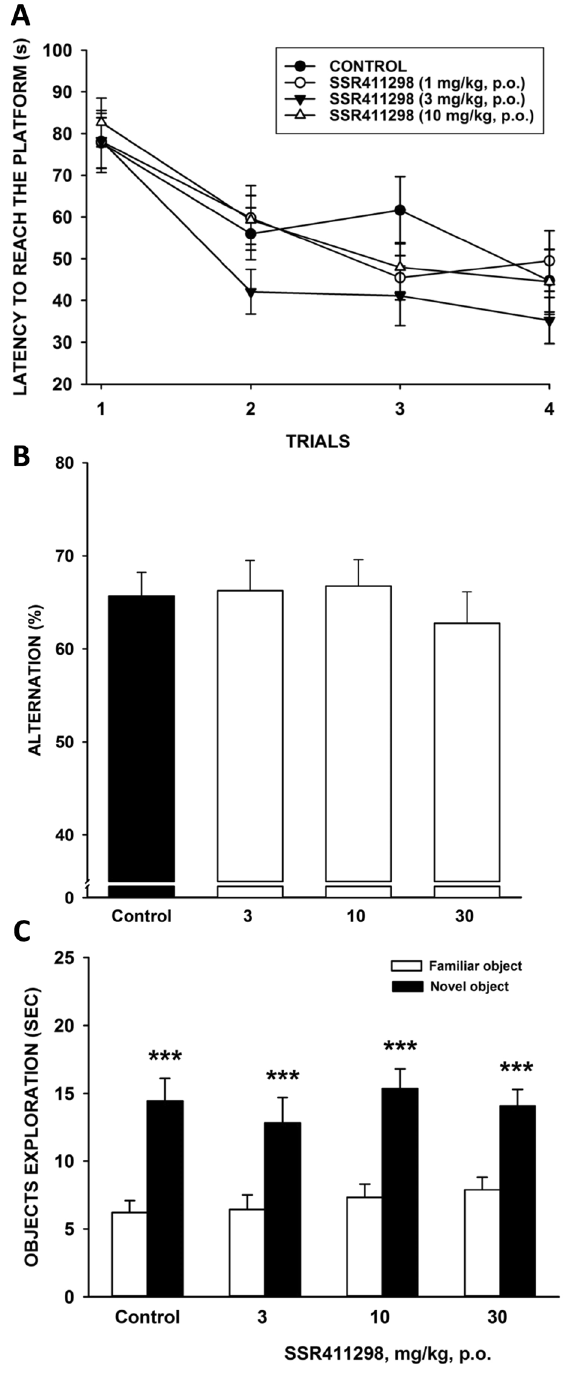
Figure 7. Effects of SSR411298 on ( A ), spatial reference memory in the Morris water maze in rats. Each line represents the average ( ± SEM) latency to reach the platform across trial. N = 10 rats per group; ( B ) episodic memory in the object recognition test in mice. Each bar represents the average ( + SEM) time spent exploring a familiar or a novel object. The interval between the acquisition and the recall session was 60 min. *** P < 0.001 novel vs familiar object at the considered treatment condition. N = 12 mice per group; ( C ) spatial working memory in the Y-maze test in mice. N = 12 mice per